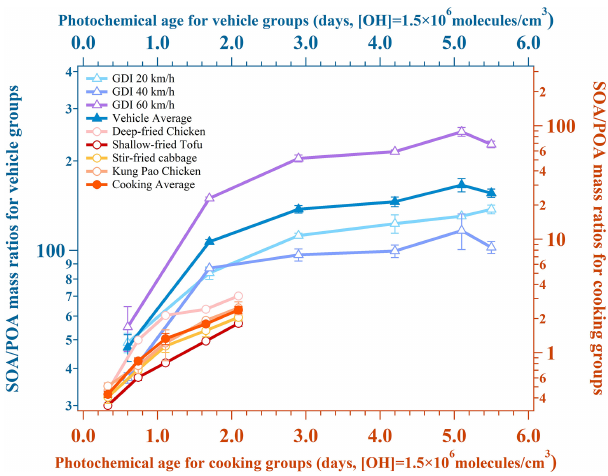
Figure 2. Secondary mass growth potential for two urban-lifestyle SOAs. The SMPS-1 determined the mass concentration of POAs, while the SMPS-2 determined the mass concentration of aged OAs, and their mass difference could be regarded as the SOAs. The aver- age data and standard deviation bars are shown in the